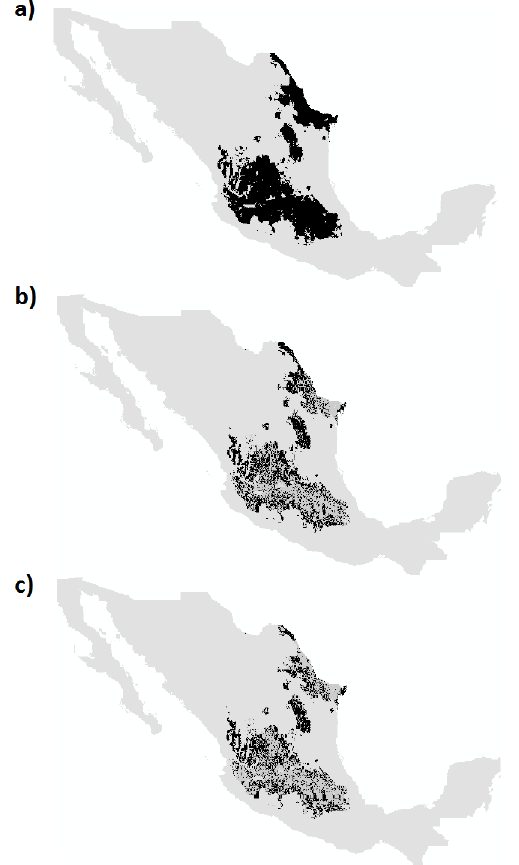
Figure 2. Distribution of Anaxyrus compactilis under three scenarios: ( a ) Potential species distribution; ( b ) extant species distribution due to habitat loss; and ( c ) extant species distribution due to habitat loss and mining activities.